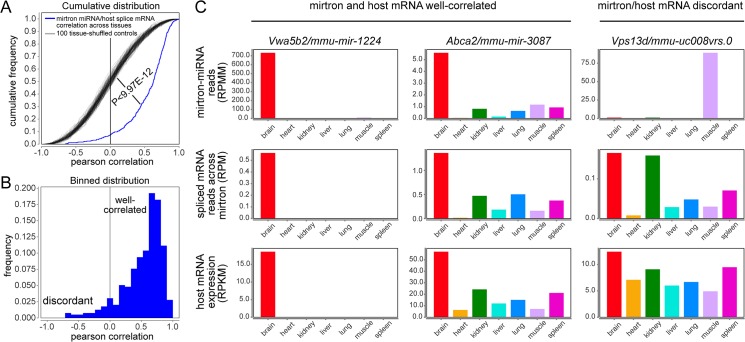
Correlation of mirtron and host gene expression.(A) We calculated the Pearson correlation coefficients of the accumulation of mouse mirtron-derived small RNAs and spliced RNA-seq reads directly flanking the mirtron across seven tissues. We also performed 100 control comparisons where the tissue origins were shuffled. The cumulative distribution function (CDF) of these correlations was plotted, and observed to be significantly positively correlated (by Mann-Whitney U-test). (B) The binned distribution of mirtron/mRNA Pearson correlation coefficients was plotted. This visualization emphasizes their positive correlation, but also highlights a subset of discordant loci. (C) Examples of correlated and discordant expression of mirtron-derived miRNAs and host mRNAs across tissues. We show host level gene expression as reads per kilobase of transcript per million mapped reads (RPKM) and the spliced exonic reads that directly cross the mirtronic locus as reads per million mapped reads (RPM). Mirtron-derived miRNAs are quantified as reads per million mapped miRNA reads (RPMM).